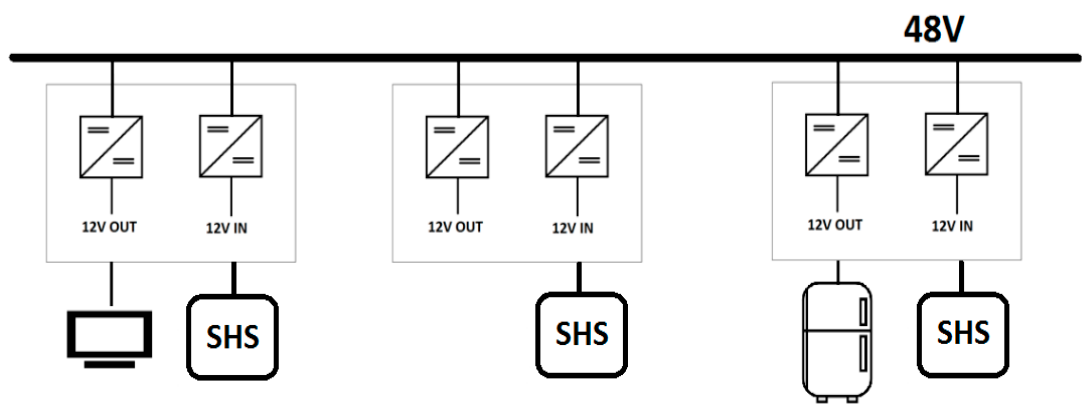
Figure 8. Interconnected SHS microgrid architecture.